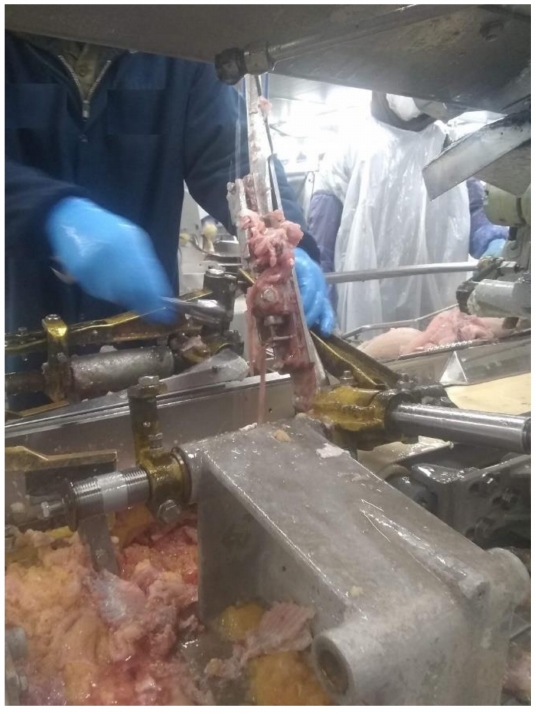
Figure 4. The manual cleaning process for the filleting